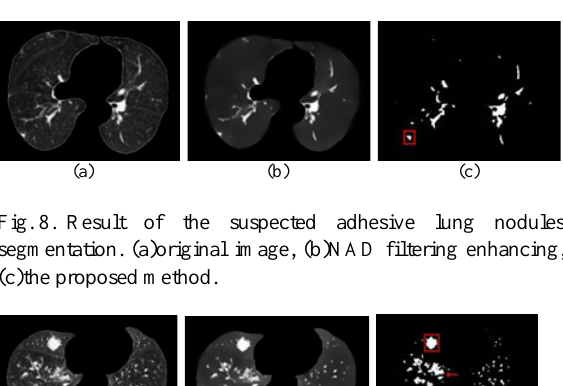
Fig. 7. Result of the suspected ground-glass opacity lung nodules. (a)original image, (b)NAD filtering enhancing, (c)the proposed method.